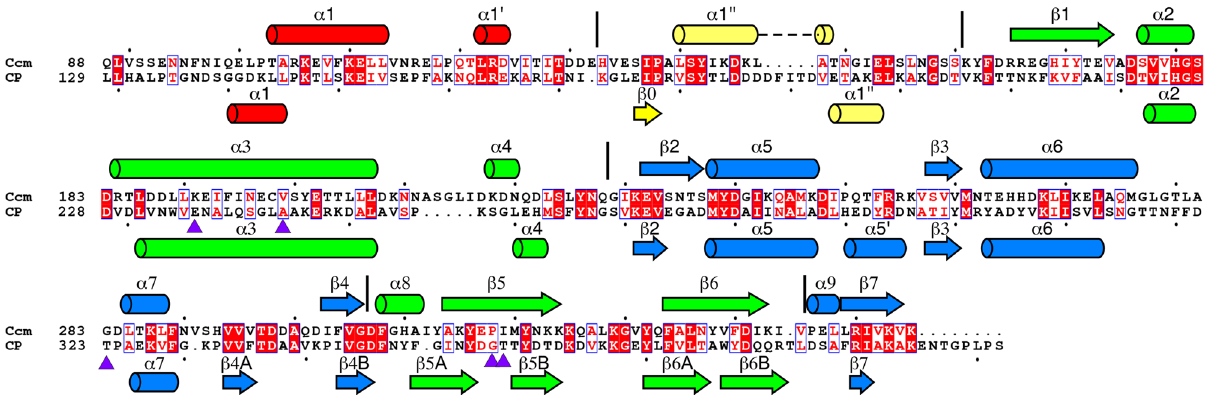
Fig. 5 Sequence and secondary structure of Ccm and CP. Sequence alignment of Ccm and CP, generated in ESpript 3.0 46 . Secondary structure elements in Ccm and CP, determined from the high-resolution structure, are shown above and below the alignment, respectively, and colored according to domain: red, N-arm; yellow, E-loop; green, P-domain; blue, A-domain. The borders between domains are indicated by the vertical lines. Locations of CP sir mutations are shown as purple triangles below the